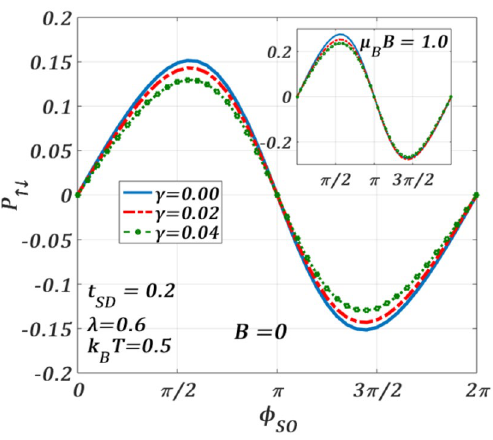
0.5 t SD 0.2, (cid:31) 0.6, eV b = = =